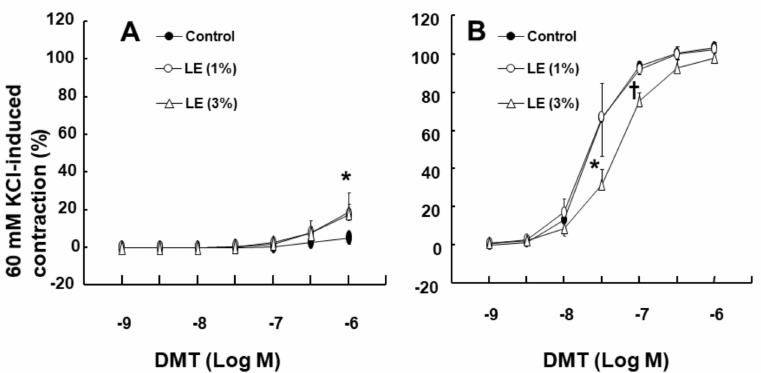
Figure 1. ( A ): Effect of endothelial denudation on the dexmedetomidine (DMT)-induced contraction in the isolated rat aorta. Data ( n = 11) are shown as mean ± standard deviation and expressed as the percentage of isotonic 60 mM KCl-induced contraction. 60 mM KCl-induced contraction was 1.68 ± 0.30 and 2.22 ± 0.59 g for endothelium-intact and endothelium-denuded aorta, respectively. n indicates the number of isolated rat aorta. * p < 0.001 versus endothelium-intact aorta. ( B ): Effect of N w -nitro-L-arginine methyl ester (L-NAME, 10 − 4 M) on the DMT-induced contraction in the endothelium-intact rat aorta. Data ( n = 6) are shown as mean ± standard deviation and expressed as the percentage of isotonic 60 mM KCl-induced contraction. 60 mM KCl-induced contraction was 1.83 ± 0.29 and 1.85 ± 0.35 g for control and L-NAME, respectively. n indicates the number of rats from which the thoracic aortae were obtained. * p < 0.001 versus control. ( C ): Effect of methyl- β - cyclodextrin (M β CD, 7 × 10 − 3 M) on the DMT-induced contraction in the endothelium-intact rat aorta. Data ( n = 6) are shown as the mean ± standard deviation and expressed as the percentage of isotonic 60 mM KCl-induced contraction. 60 mM KCl-induced contraction was 1.81 ± 0.13 and 1.76 ± 0.27 g for control and M β CD, respectively. n indicates the number of rats from which the thoracic aortae were obtained. * p < 0.001 versus control.